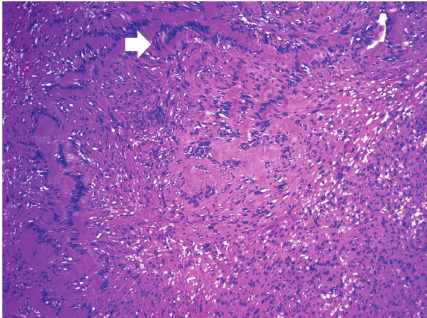
Figure 4: H&E stain ( × 20) of the plexiform schwannoma, display- ing the typical palisading organisation (white